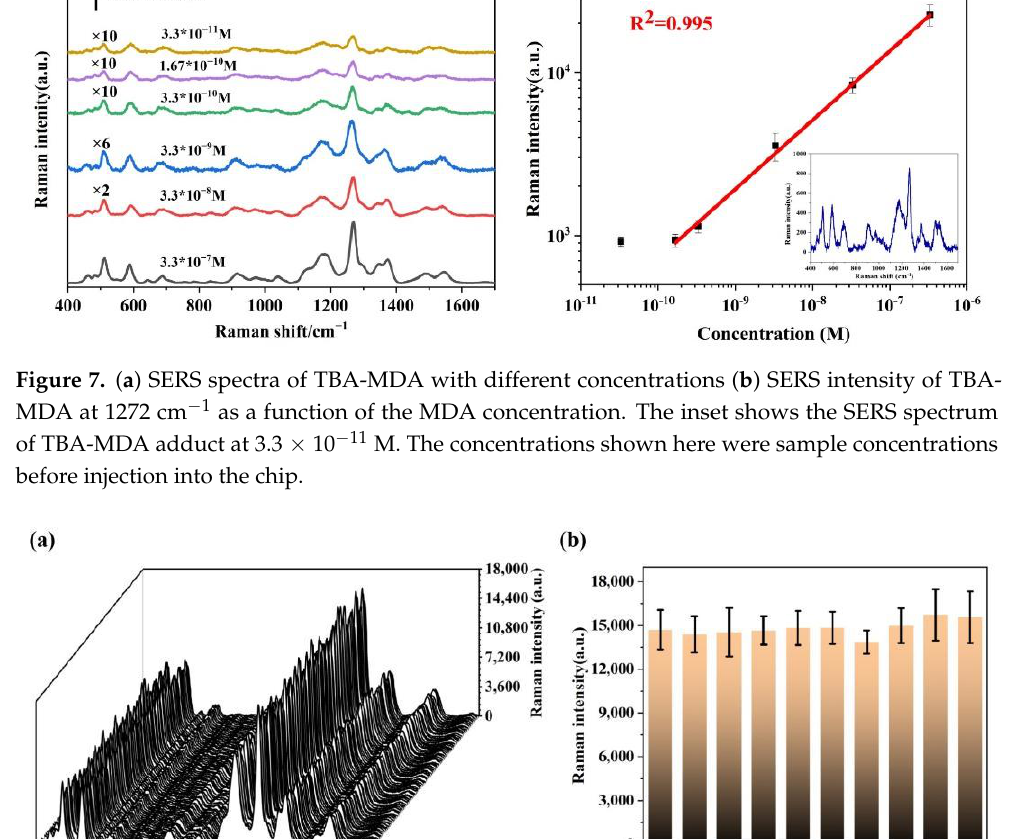
Table 1. Five MDA detection methods reported in recent years.